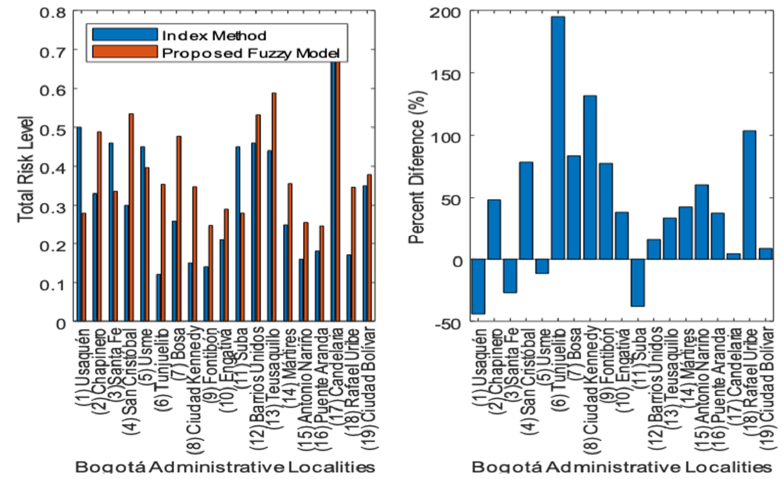
Figure 12. Percentage differences between the numeric value of the total risk estimations made by the index method and the fuzzy model for Bogota’s administrative localities. At left: values of total risk. At right: percentage difference.